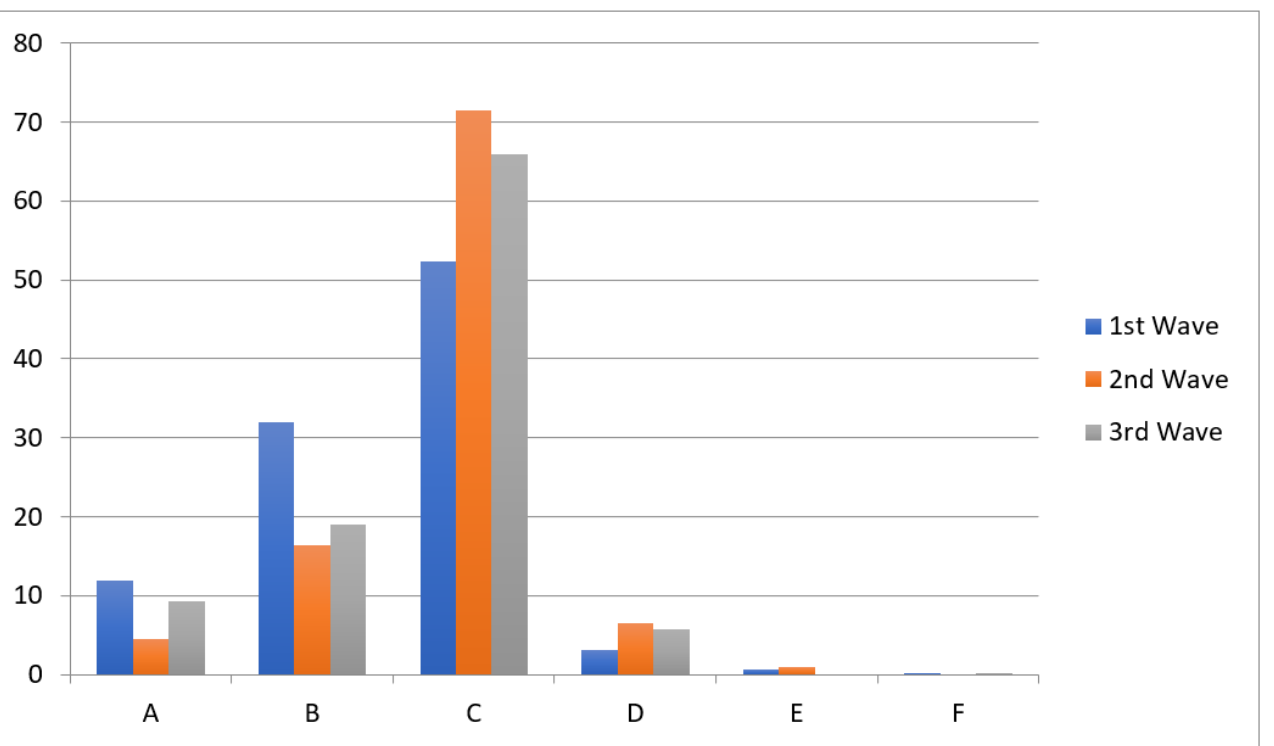
Figure 1. Ordinal scale for clinical improvement on the day of admission for patients hospitalized in the Hospital for Infectious Diseases in Warsaw due to COVID-19 between March 2020 and November 2021 ( p < 0.001). Results are presented in percentage (%) of patients ( y -axis). Legend: (A) Hospitalized, not requiring oxygen supplementation and not requiring medical care. (B) Hospitalized, not requiring oxygen supplementation but requiring medical care. (C) Hospitalized, requiring normal oxygen supplementation. (D) Hospitalized, requiring non-invasive ventilation with high-flow oxygen equipment (helmet, high-flow oxygen nasal cannula, HFNC). (E) Hospitalized, requir- ing invasive mechanical ventilation or ECMO. (F) Death.